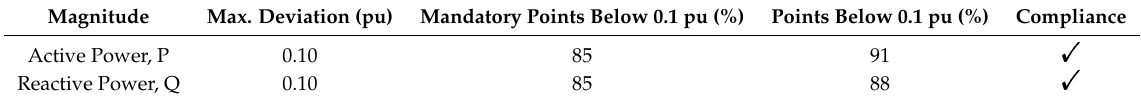
Table 7. Verification of the PVVC validation criteria applied to the IEC generic WT model at the low voltage side, operating at partial load conditions: 690 V, measurement point 2.